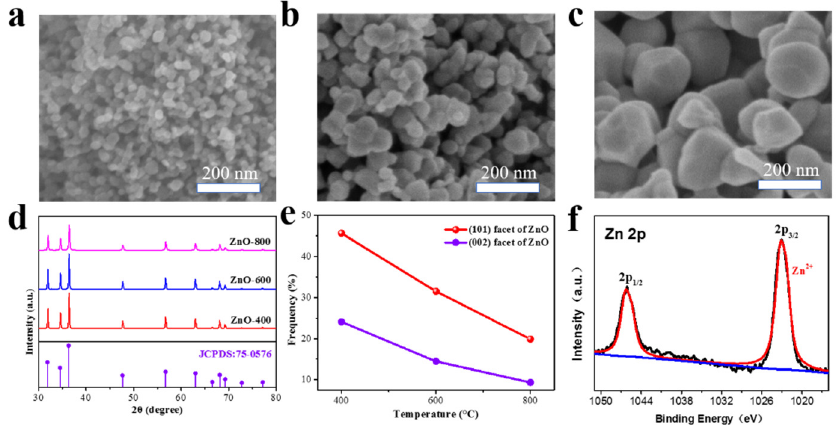
Figure 1. SEM images of ( a ) ZnO-400, ( b ) ZnO-600, and ( c )ZnO-800. ( d ) XRD patterns and ( e ) (101) and (002) facets proportion of different ZnO catalysts. ( f ) Zn XPS spectrum of